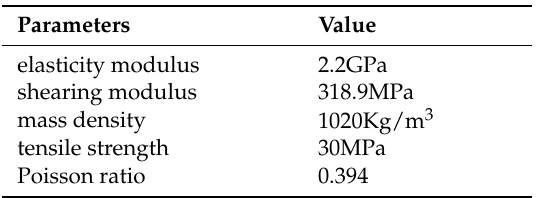
Table 4. Mechanical property parameters of ABS